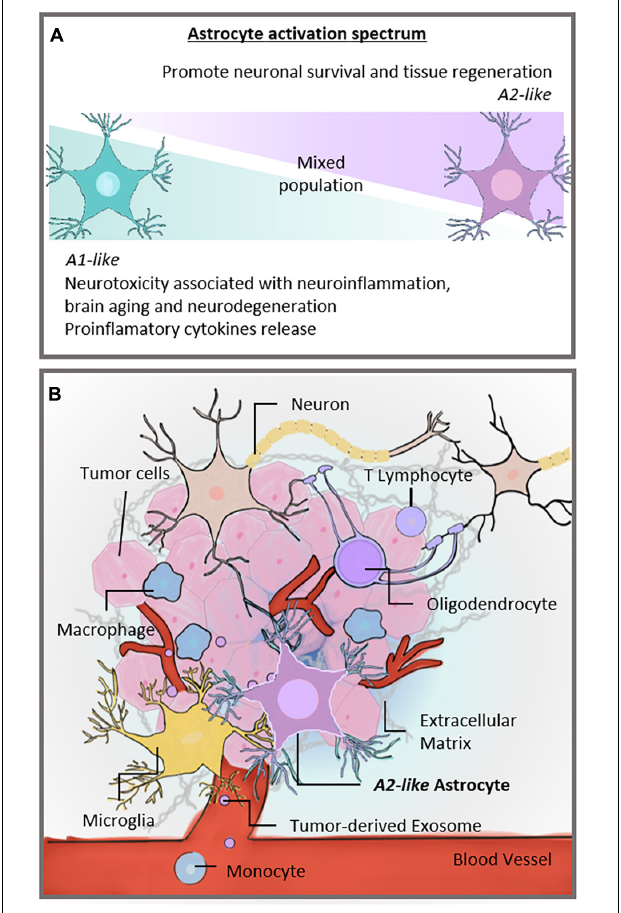
FIGURE 1 | Activation spectrum of astrocytes and the brain TME. (A) Astrocytic spectrum of activation. Recent studies proposed that astrocytes became reactive and assumed an activation spectrum characterized by two extremes, the A1 and A2 phenotypes. The A1 -astrocyte phenotype is associated with neurotoxic and neuroinflammatory effects, whereas the A2 -astrocyte phenotype is related to neuroprotection. (B) Different cells constitute the TME of GBs. Neurons, microglia, and glial cells, such as astrocytes and oligodendrocytes, share the brain milieu with tumor cells, establishing a complex ecosystem. These cells are surrounded by extracellular matrix and susceptible to signals carried by tumor-derived exosomes. In addition, monocytes can be recruited to the brain site and contribute to forming the TME. Our hypothesis is that astrocytes in the TME assume an A2 -like astrocyte phenotype, partly explaining GB malignancy. TME, tumor microenvironment; CNS, central nervous system; GB,